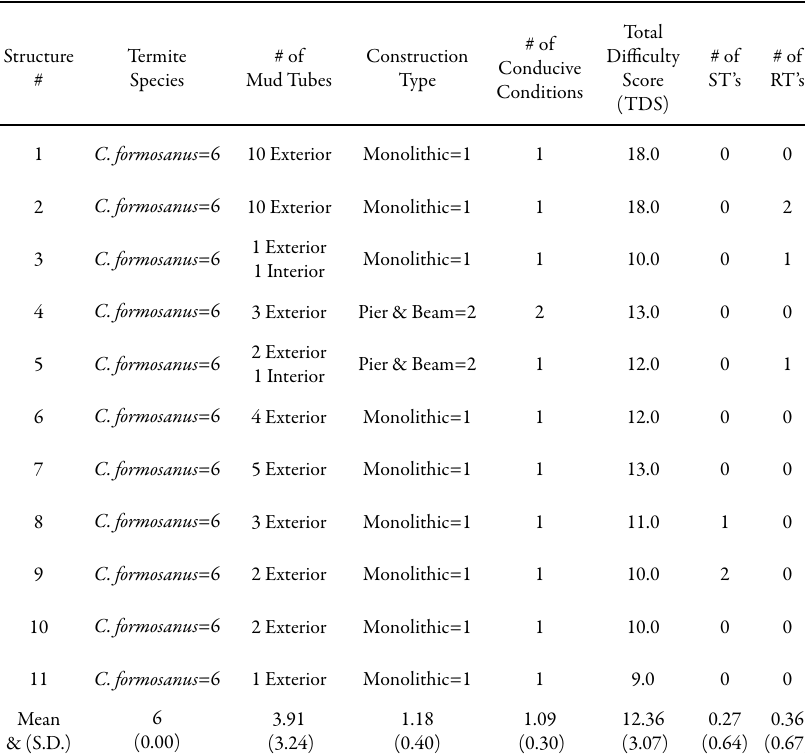
Table 3. Data-populated scoring rubric developed for, and used in these trials to standardize the total difficulty score (TDS) associated with treatment of each